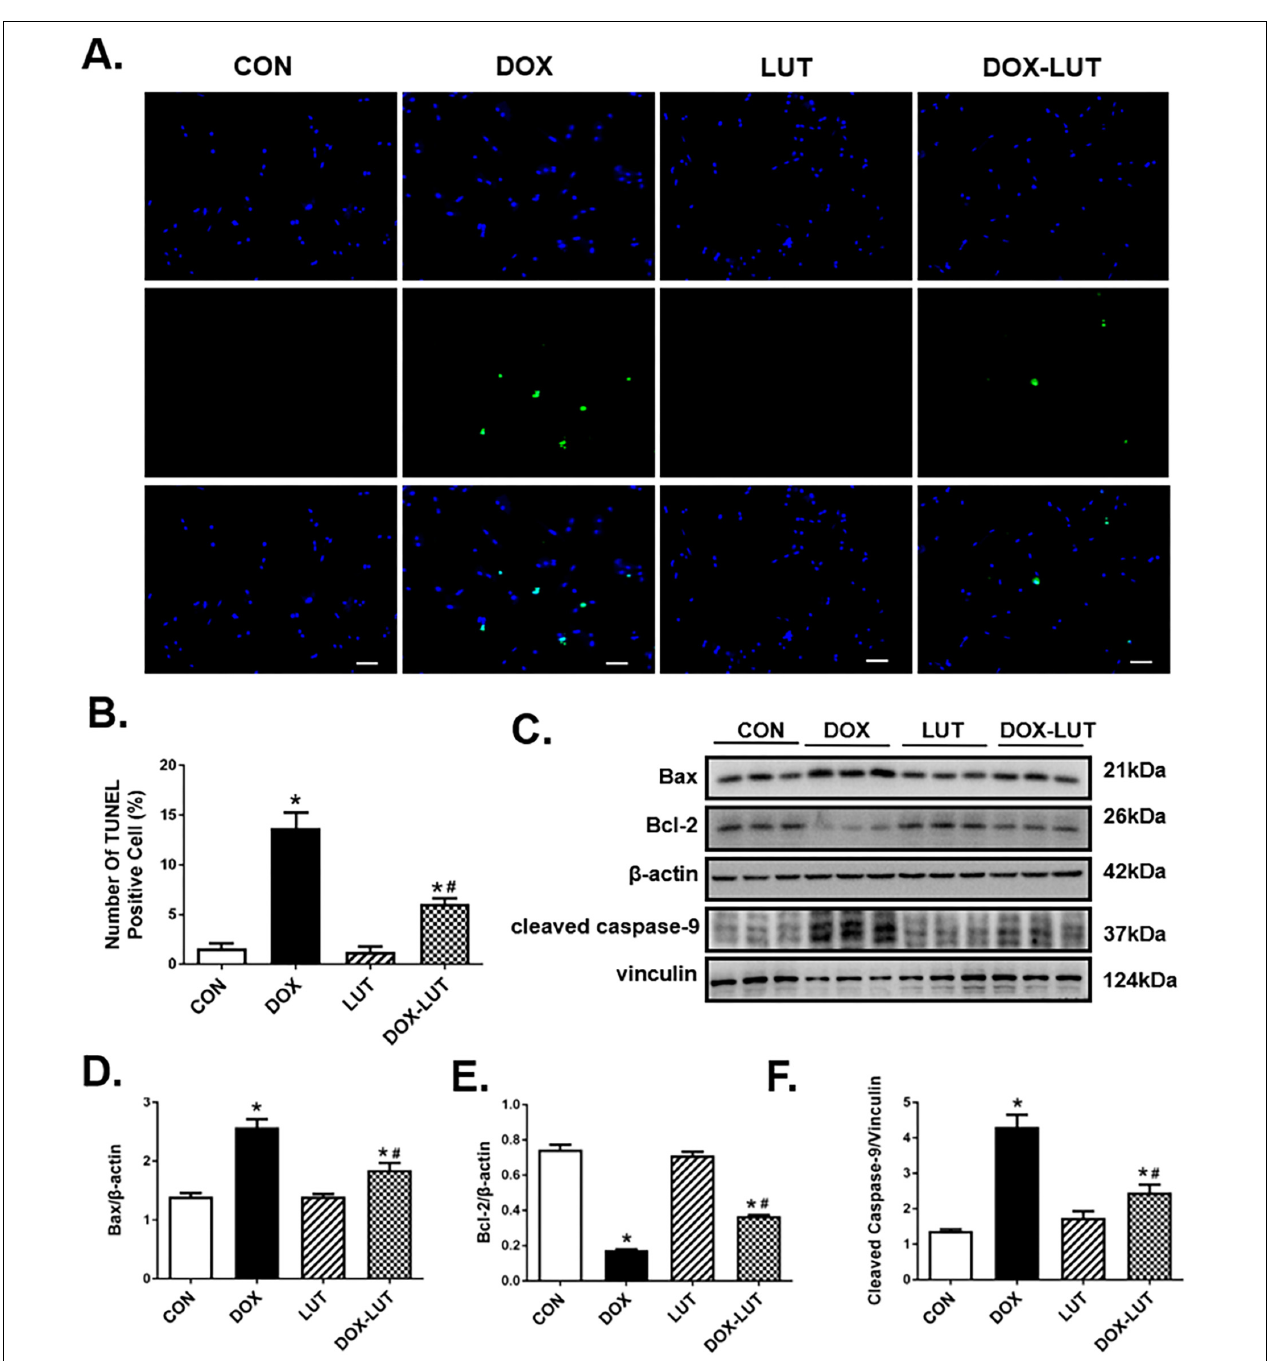
FIGURE 2 | Effect luteolin treatment on doxorubicin-induced cardiomyocyte apoptosis. (A) Representative TUNEL staining depicting AMCM apoptosis after doxorubicin and luteolin treatment. All nuclei were stained with DAPI (blue), whereas TUNEL-positive nuclei were visualized using green fluorescence. Original magnification = 200 × . (B) Quantified TUNEL apoptosis manifested as percentage of TUNEL-positive cells from nine fields per group. (C) Representative western blot images of AMCM apoptosis using Bax, Bcl-2 and cleaved caspase-9. (D–F) Quantitative analysis of cardiomyocyte apoptosis using Bax, Bcl-2 and cleaved caspase-9. Scale bars = 50 µ m. Mean ± SEM, n = 3 independent experiment. * p < 0.05 vs. CON group, # p < 0.05 vs. DOX group.